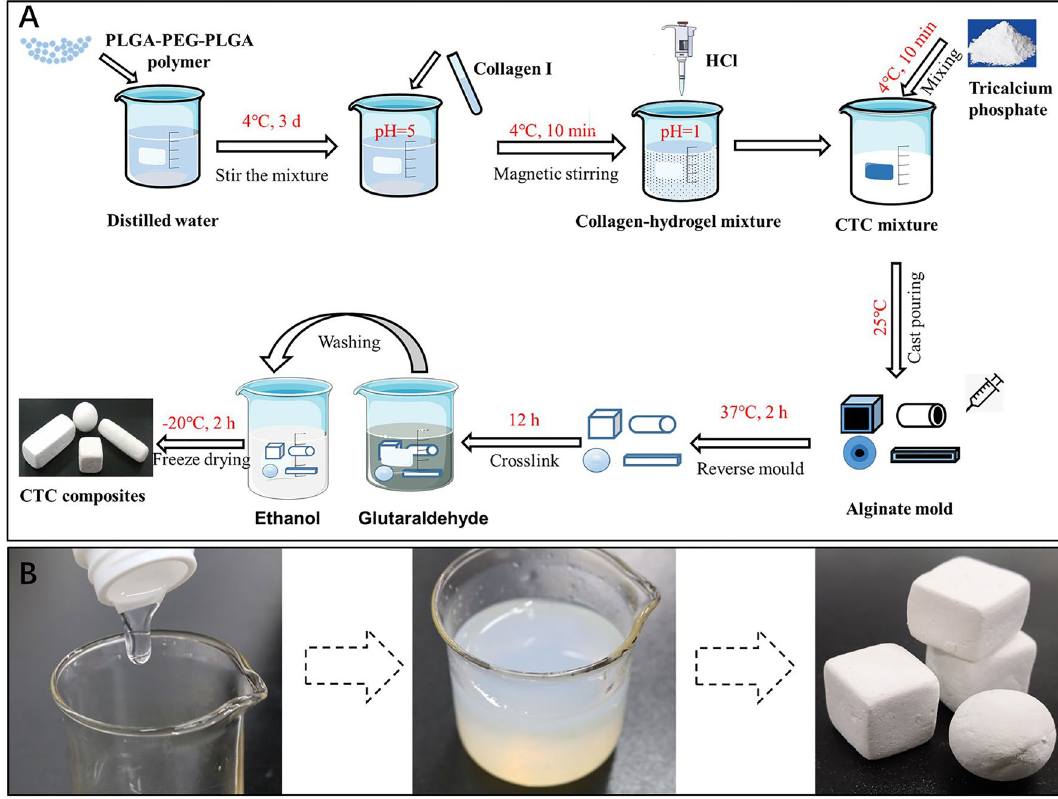
Figure 2. The schematic diagram and process of CTC bio-composite preparation. ( A ) The schematic diagram of material preparation. The ratio of collagen I, thermosensitive hydrogel and calcium phosphate was